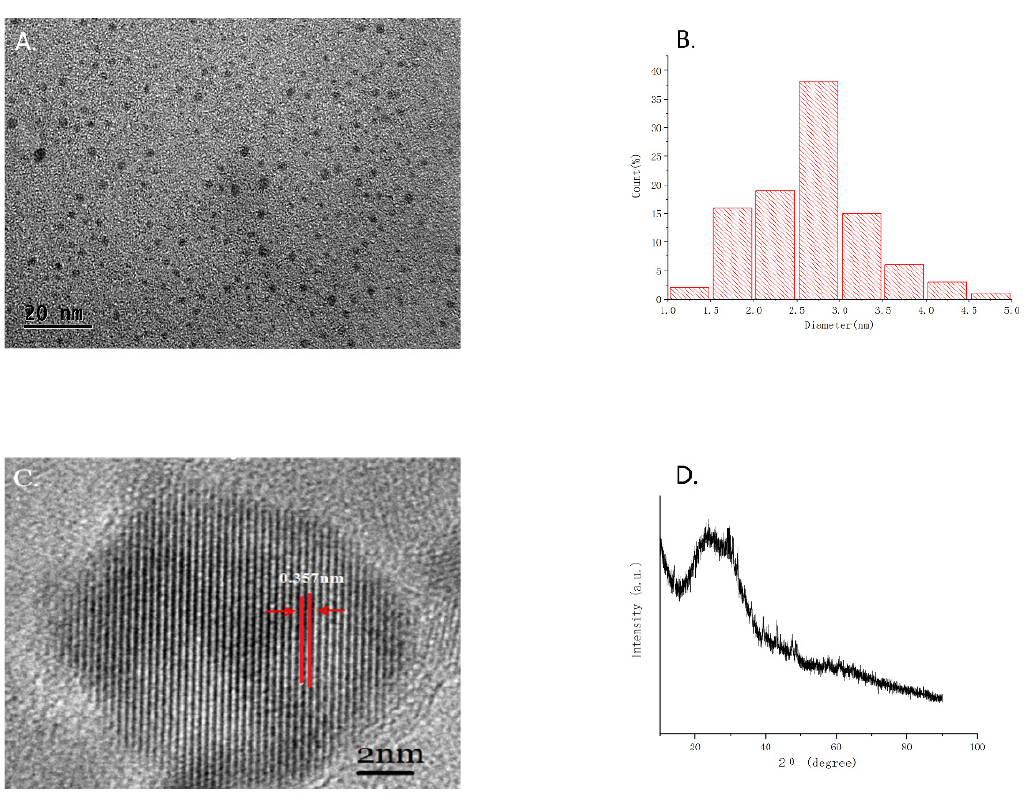
Figure 1. ( A ) Transmission electron microscopy (TEM) images of GRR-CDs displaying ultra-small particles. ( B ) Histogram